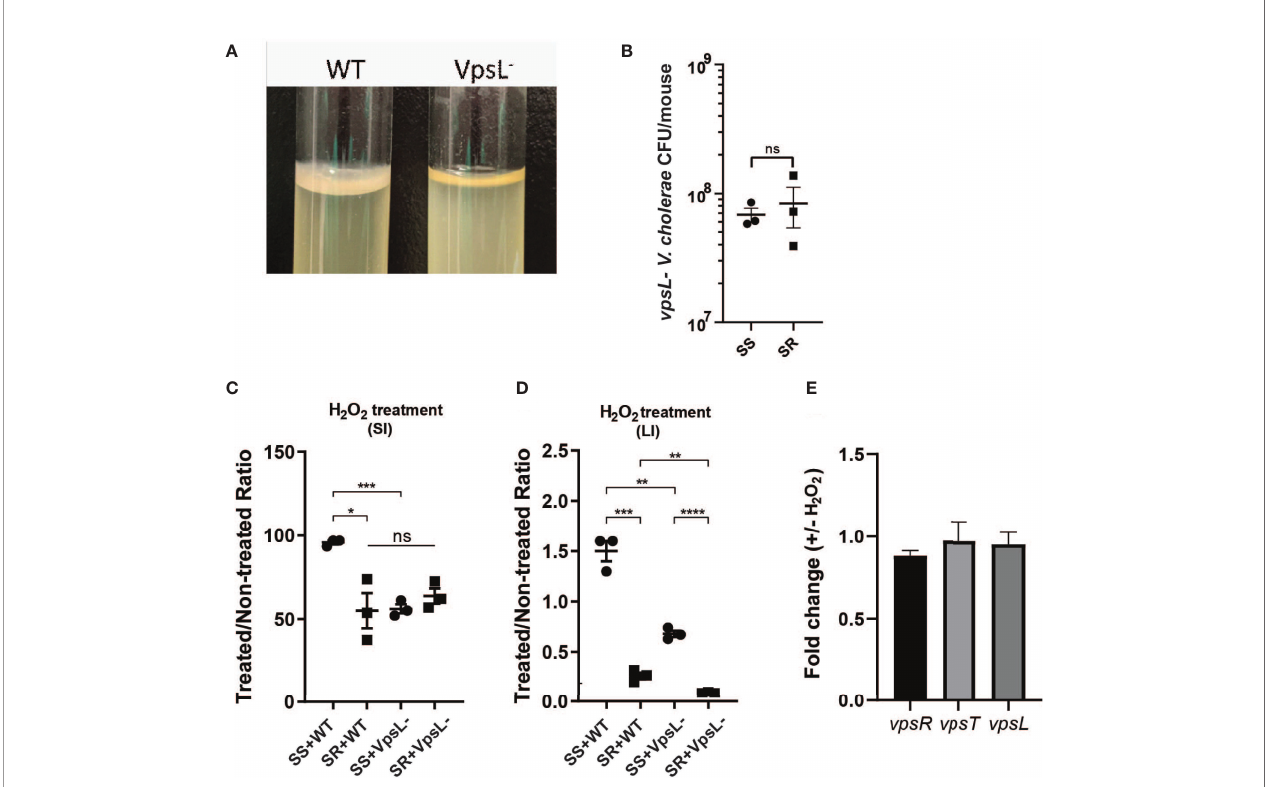
FIGURE 4 | Presence of different commensal microbes during infection drives different bio fi lm-dependent V. cholerae oxidative stress resistances. (A) Con fi rmation of disruption of bio fi lm formation by vpsL gene deletion. (B) vpsL mutant V. cholerae colonization co-gavaged with indicated model microbiota. Survival of V. cholerae strains in (C) small intestine and (D) large intestine of antibiotic-cleared suckling mice co-colonized with indicated commensal communities after hydrogen peroxide treatment. (E) qPCR quanti fi cation of VPS gene expression in vitro after hydrogen peroxide treatment (n = 3, t test, *P < 0.05; **P < 0.01; ***P < 0.001; ****P < 0.0001; ns, not signi fi